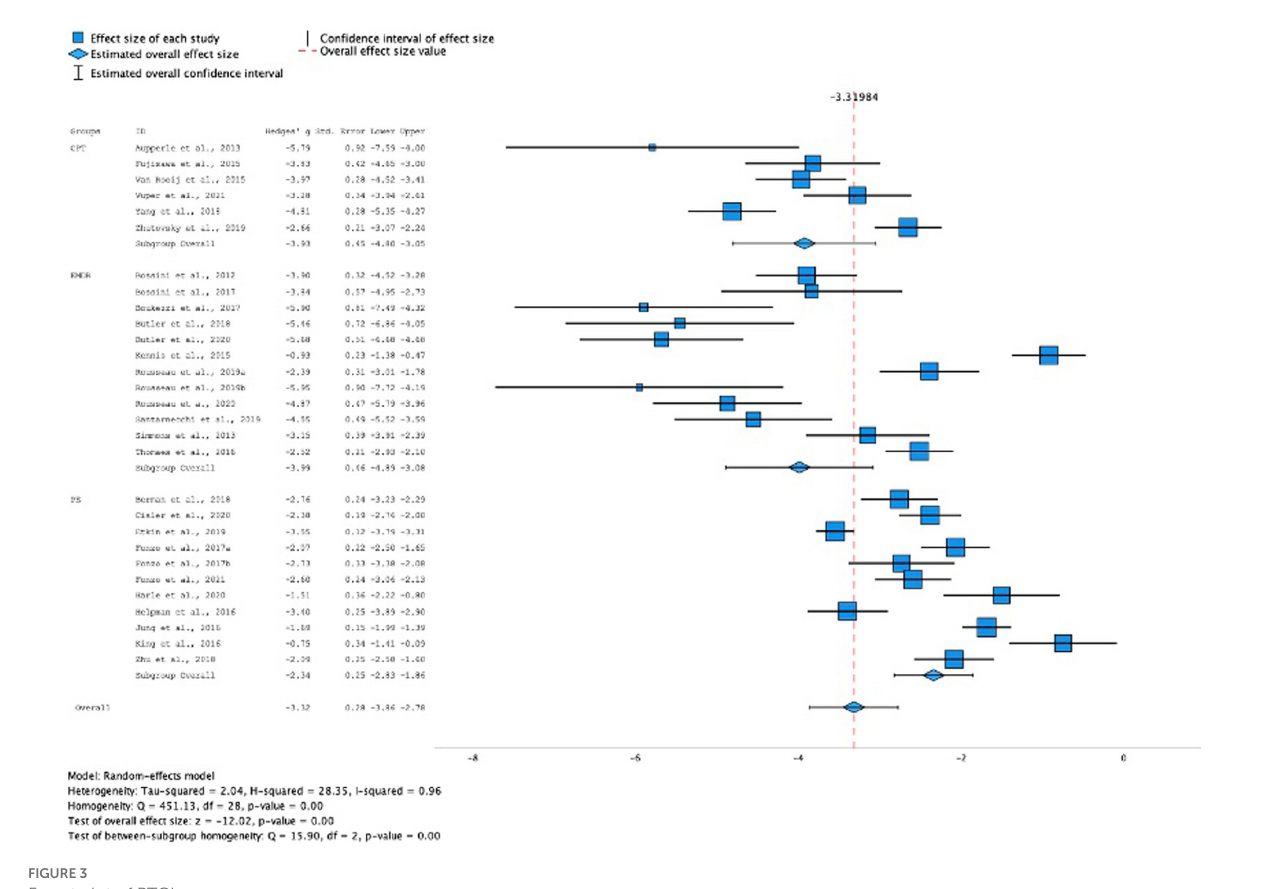
FIGURE 3 Forest plot of PTGI